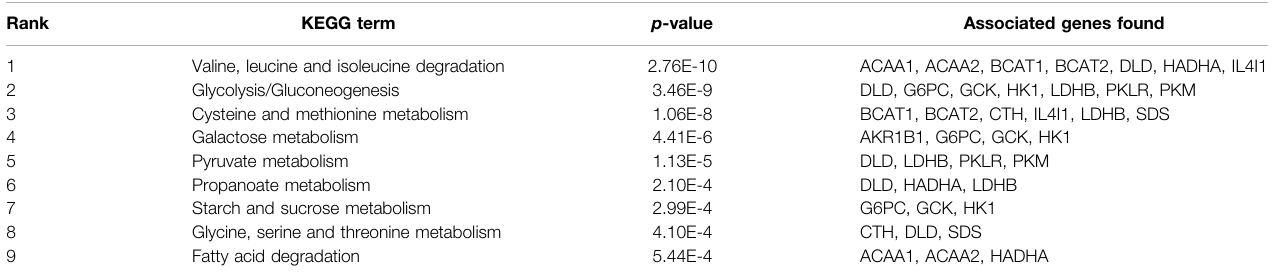
TABLE 3 | The results of KEGG correlative pathways of LBG major active ingredient related targets were analyzed by Cytoscape 3.7.1 software. Rank KEGG term p -value Associated genes